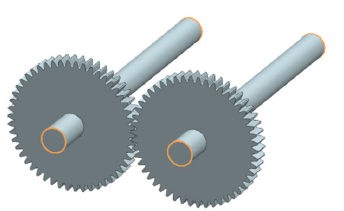
Figure 13. Boundary conditions. ( a ) Gear pair. ( b ) Torque split model.